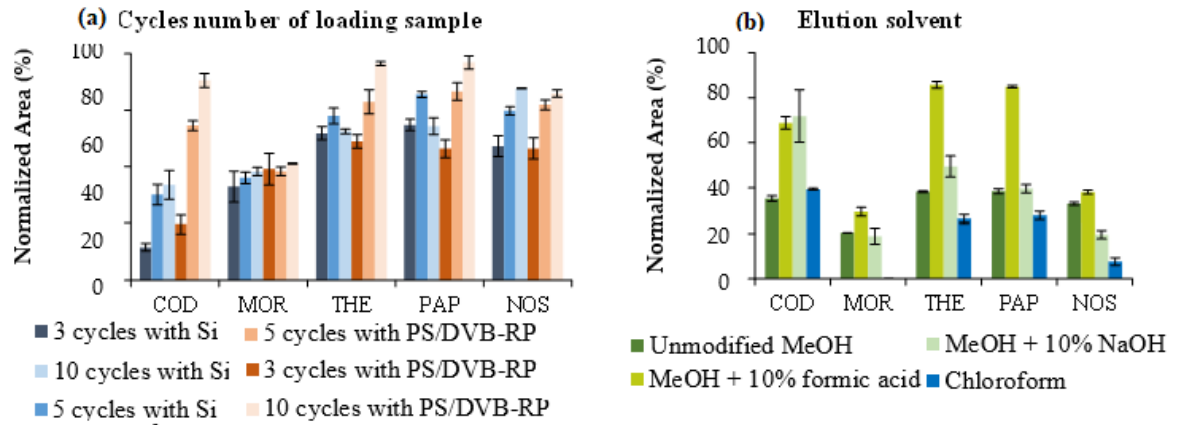
Figure 4. Normalized areas (%) obtained with the silica and PS/DVB-RP cartridge with 3, 5 and 10 draw–effect cycles in the loading step at pH 7 ( a ) and with the PS/DVB-RP cartridge with a different elution solvent with a pH of 7 in the loading step ( b ). All assays were performed with 5 mg/L standard solutions in triplicate; error bars indicate the relative standard deviations (RSDs %).